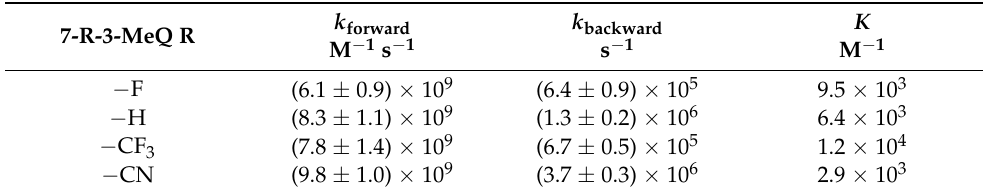
Table 1. Rate constants of forward and backward reactions and equilibrium constants for 3-MeQ and 7-R-3-MeQ derivatives 1 Figure 6. Plots of the observed pseudo-first-order rate constants of the formation of the 370 nm absorption as a function of 3-MeQ (●) and 7-CN-3-MeQ (  ) concentration in N 2 O-saturated aqueous solutions at pH = 7 containing 0.01 M NaN 3.